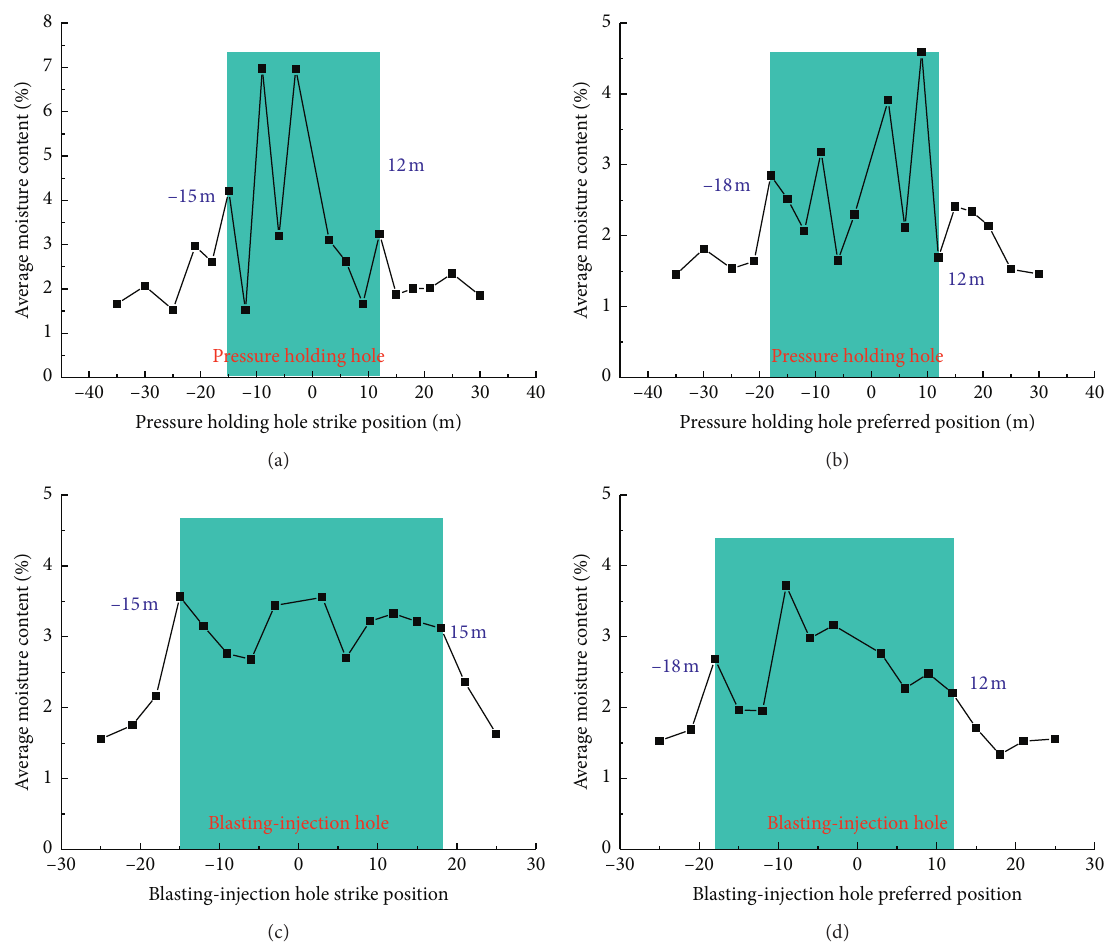
Figure 11: Relationship between test location and average moisture